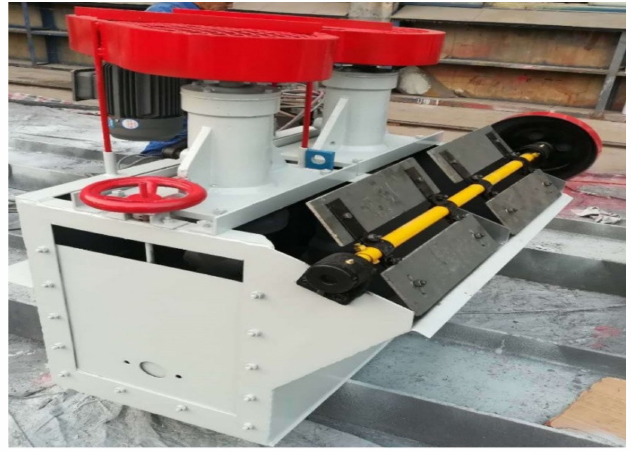
Figure 9. Froth paddles